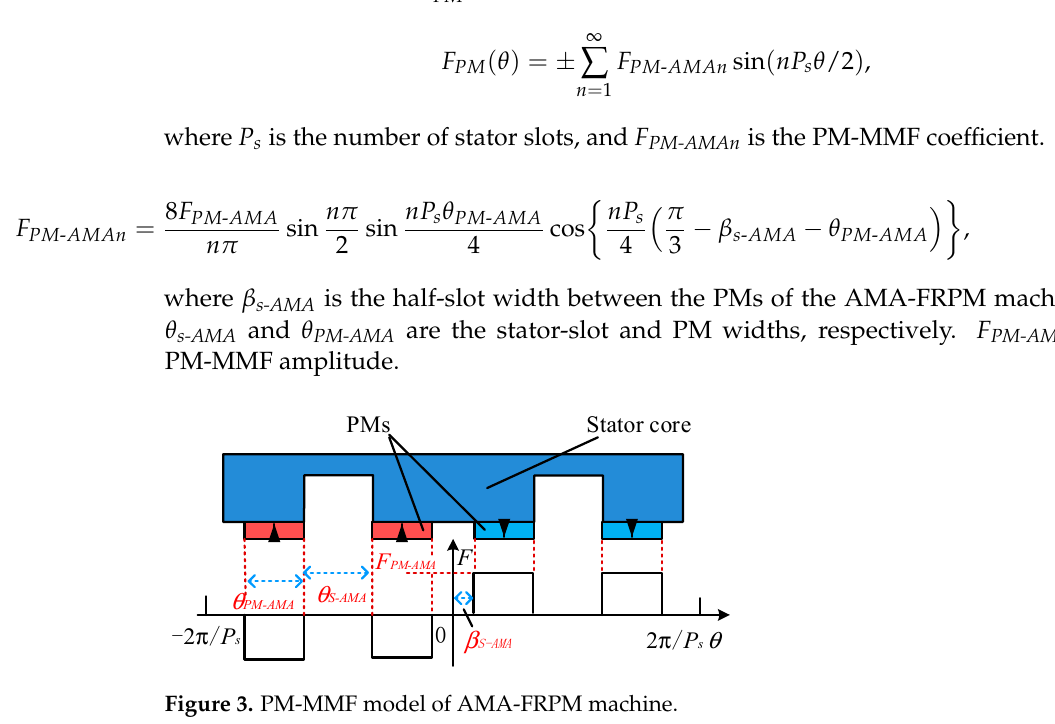
Figure 3. PM-MMF model of AMA-FRPM machine.